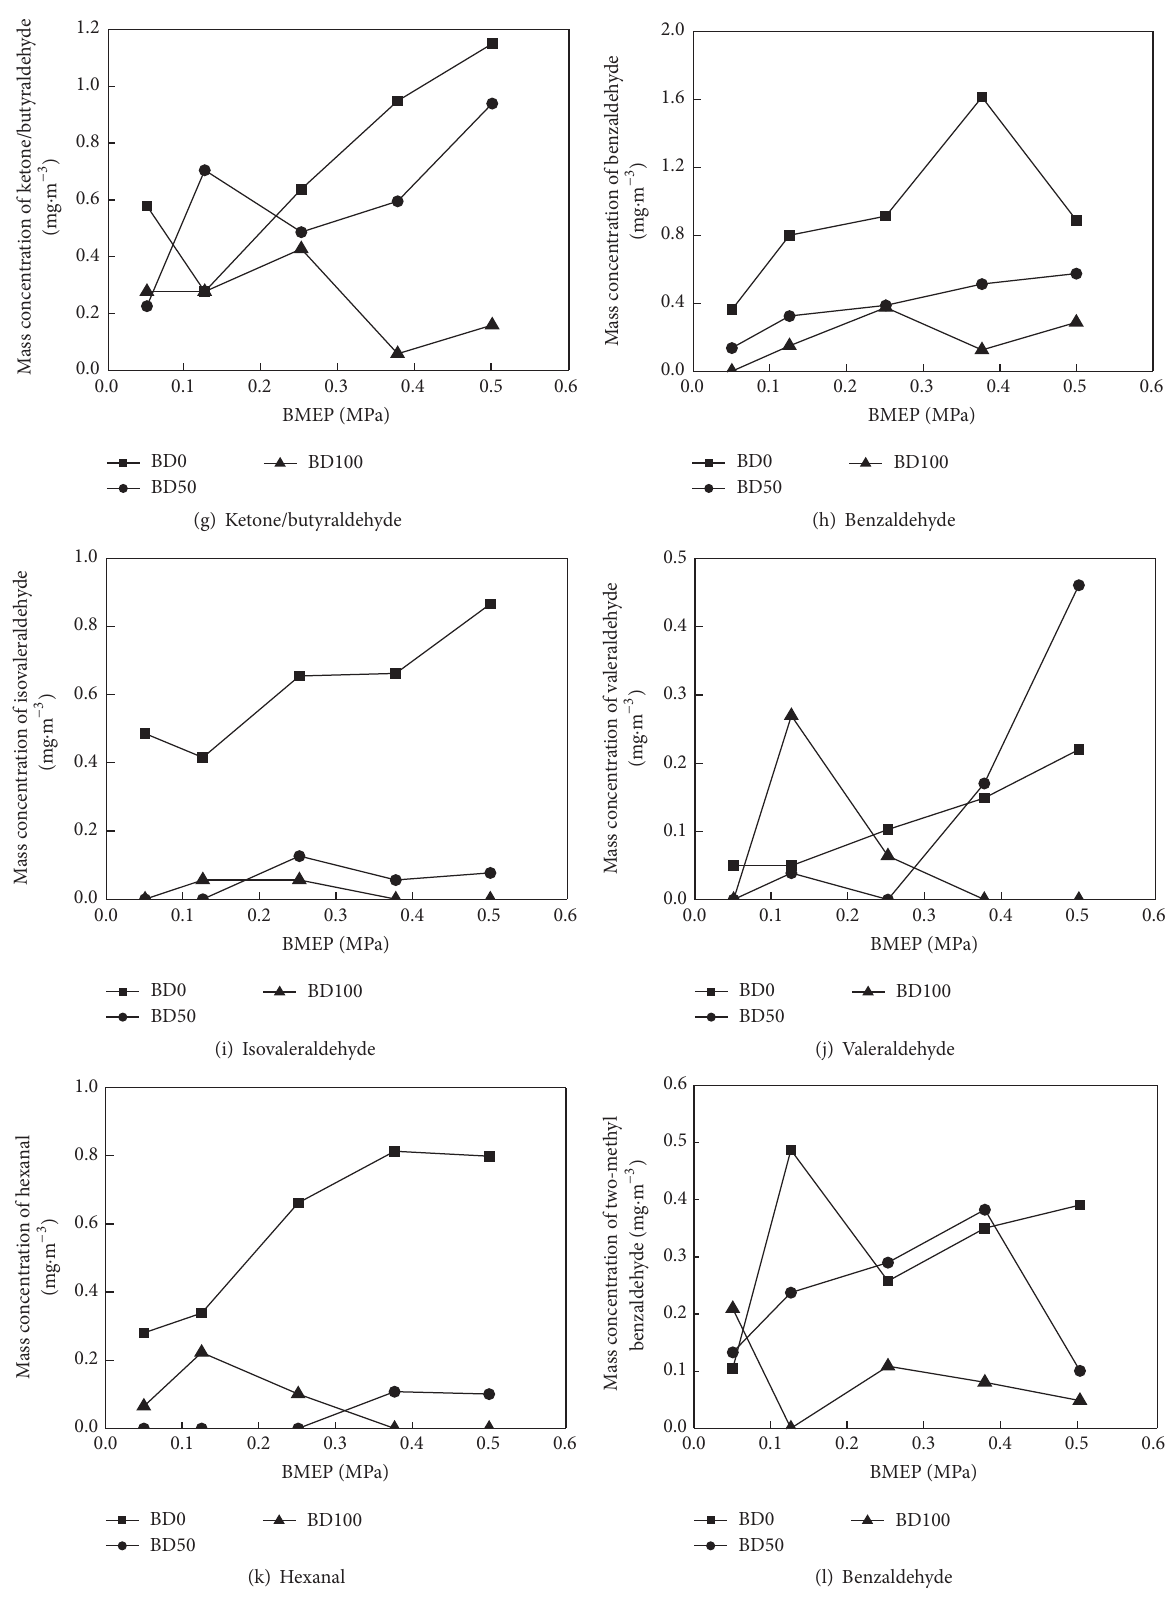
Figure 2: Specific carbonyl compounds emission with engine